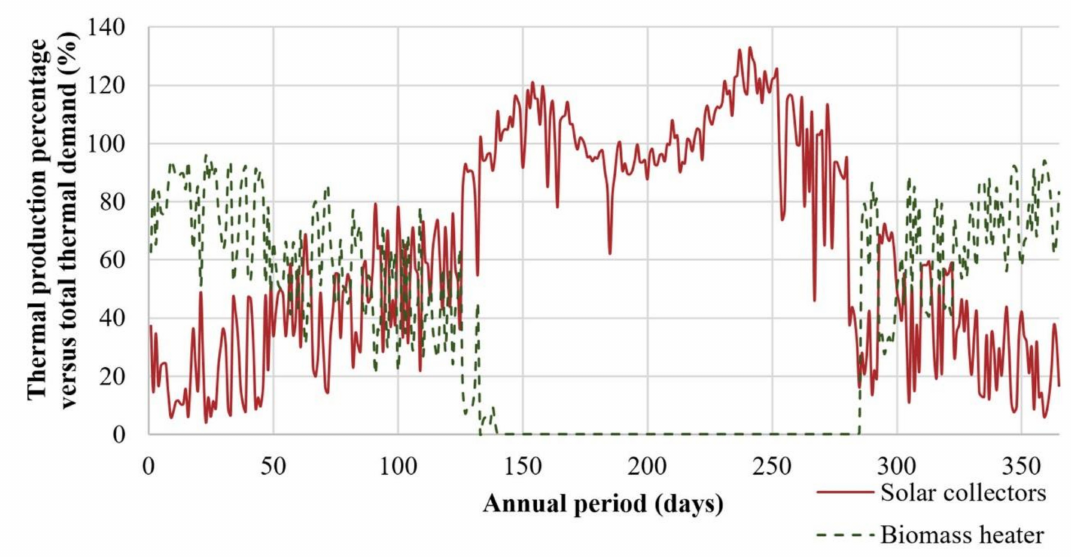
Figure 21. Annual fluctuation of the daily fractions of the solar collectors and the biomass thermal energy production versus the thermal energy